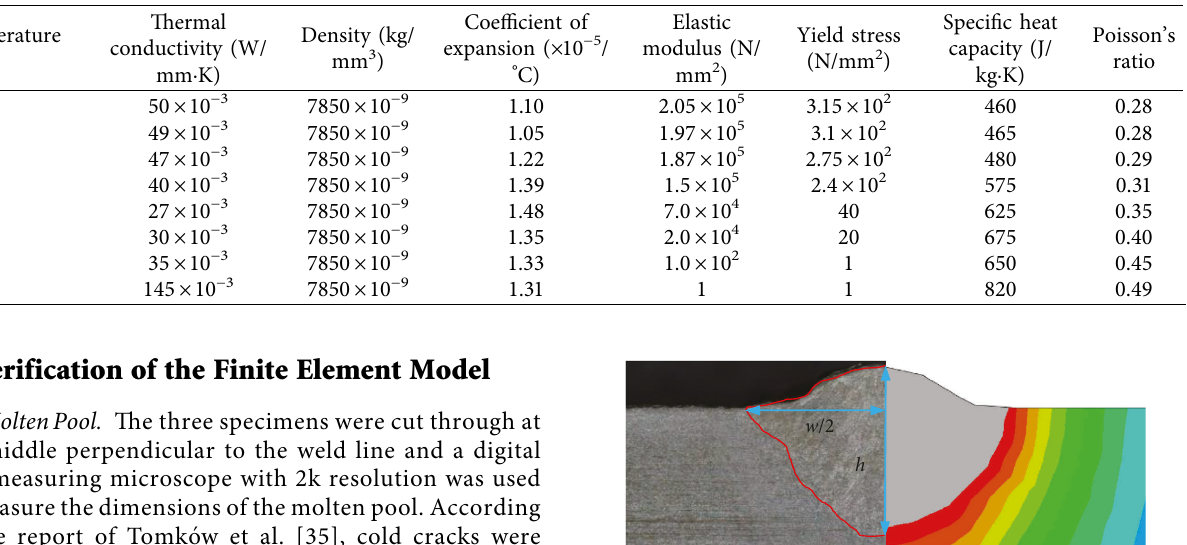
Table 5: Material properties of Q345qD steel as a function of temperature.